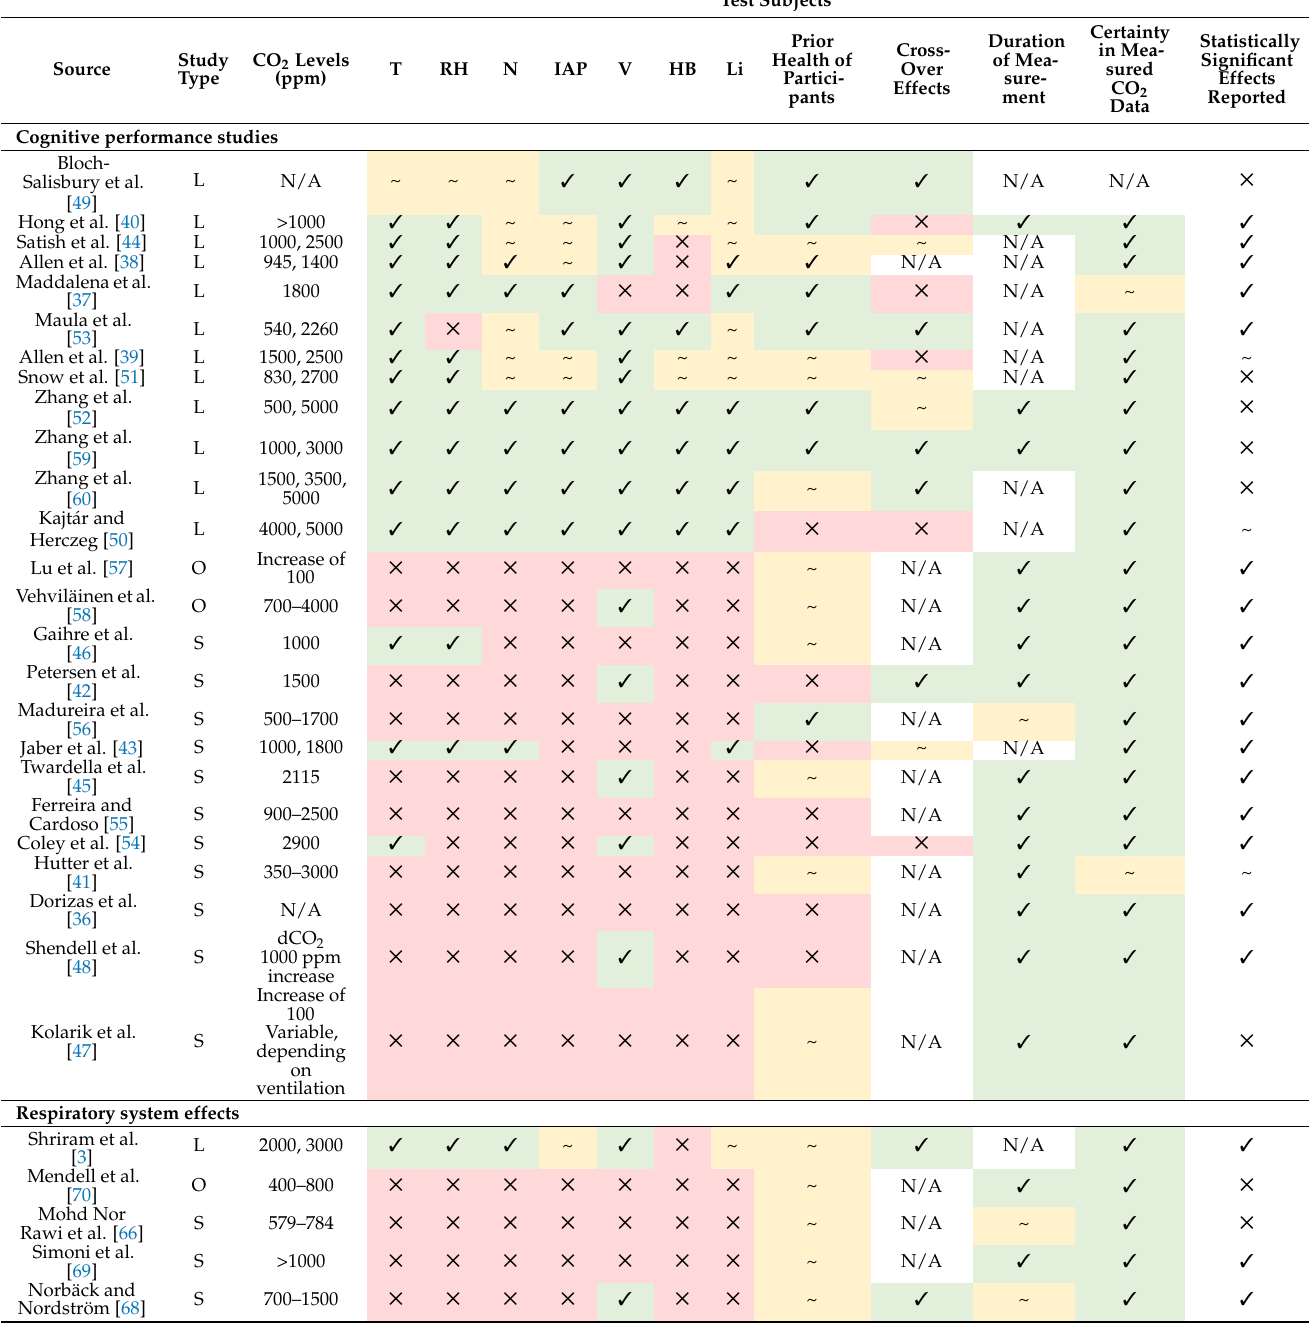
Table 2. A comparison of each investigation against the study design criteria, green/ (cid:51) = satisfactory, yellow/~ = unclear and red/ (cid:53) = unsatisfactory. For the confounding factors, T = temperature, RH = relative humidity, N = noise, IAP = indoor air pollutants, V = ventilation, HB = human bio-effluents and Li = lighting. For the study type, L = laboratory or controlled setting, S = school or daycare based, O = office based and H = home